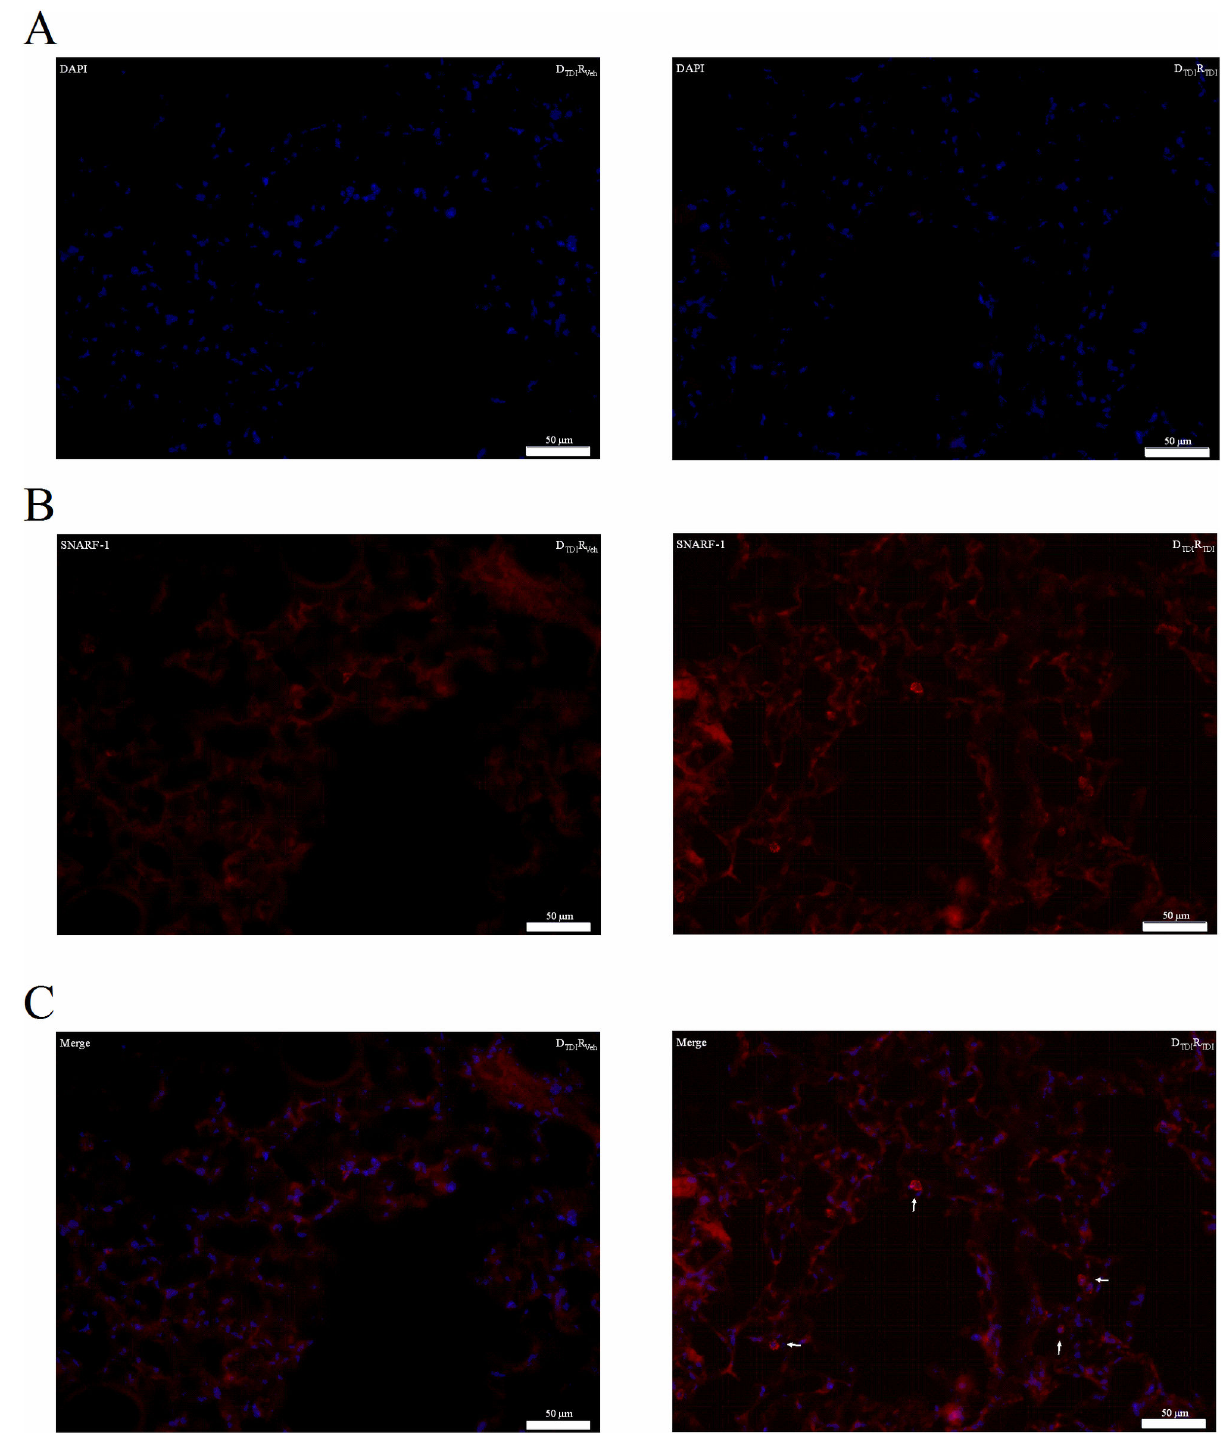
Figure 4. Transferred B-lymphocytes are present in the lungs of TDI challenged wild type BALB/c mice. Freshly isolated B- lymphocytes of the auricular lymph nodes of TDI-sensitized mice were labeled with DAPI and SNARF-1 carboxylic acid acetate and transferred into naïve wild type BALB/c mice. 5x106 labeled B-lymphocytes were transferred. Three days after the transfer mice were challenged with TDI and cryostat sections were made. Experimental groups for the adoptive transfer setup are identical to those of Figure 2 (DTDIRVeh and DTDIRTDI). Figure C shows the merged picture of the DAPI (A) and SNARF-1 (B) staining. doi: 10.1371/journal.pone.0083228.g004 PLOS ONE |